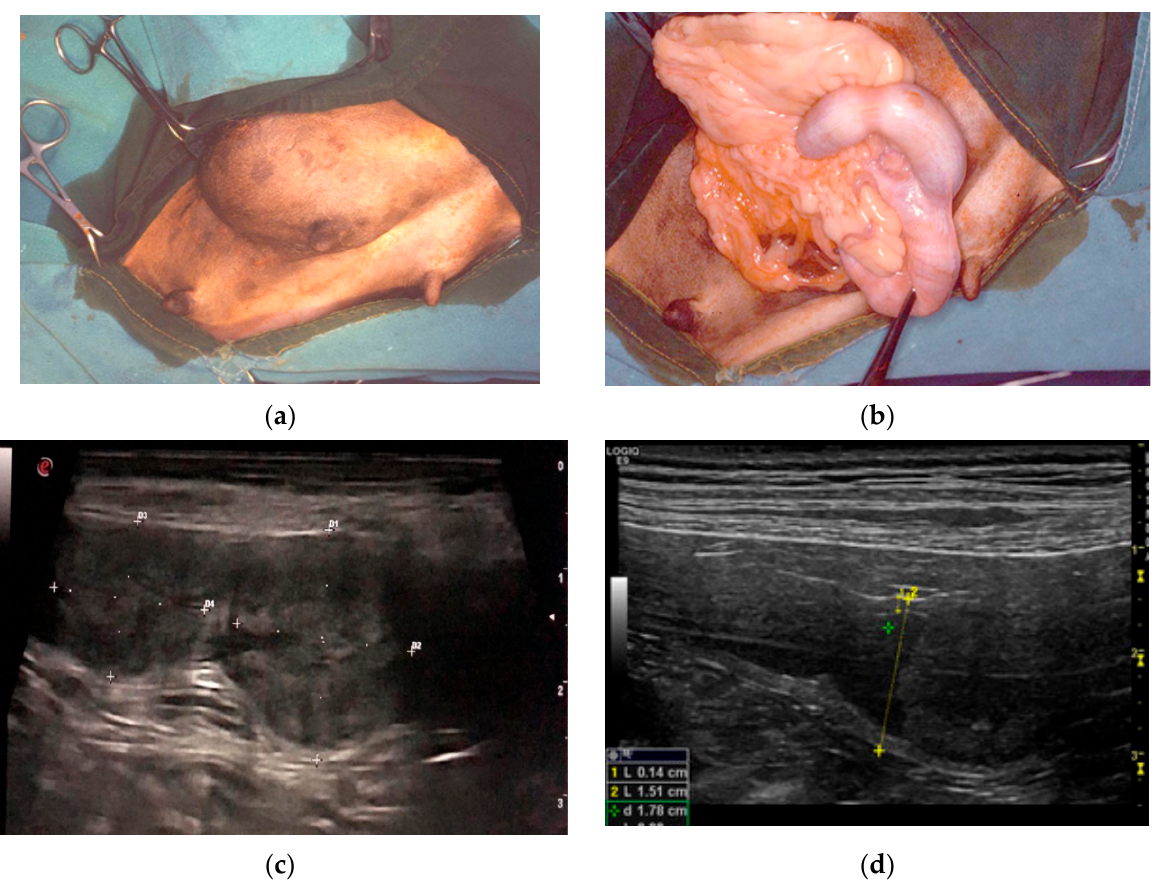
Figure 1. Clinical findings in three different cases of pseudo-placentational endometrial hyperplasia: ( a ) inguinal hernia with a uterine content in case D2; ( b ) at the opening of the hernia, the uterus with segmental swelling is evident; ( c ) ultrasound appearance of the lesion, resembling a placental remnant in case D4; D = distance ( d ) ultrasound appearance of the lesion in case D5, L= length, D =